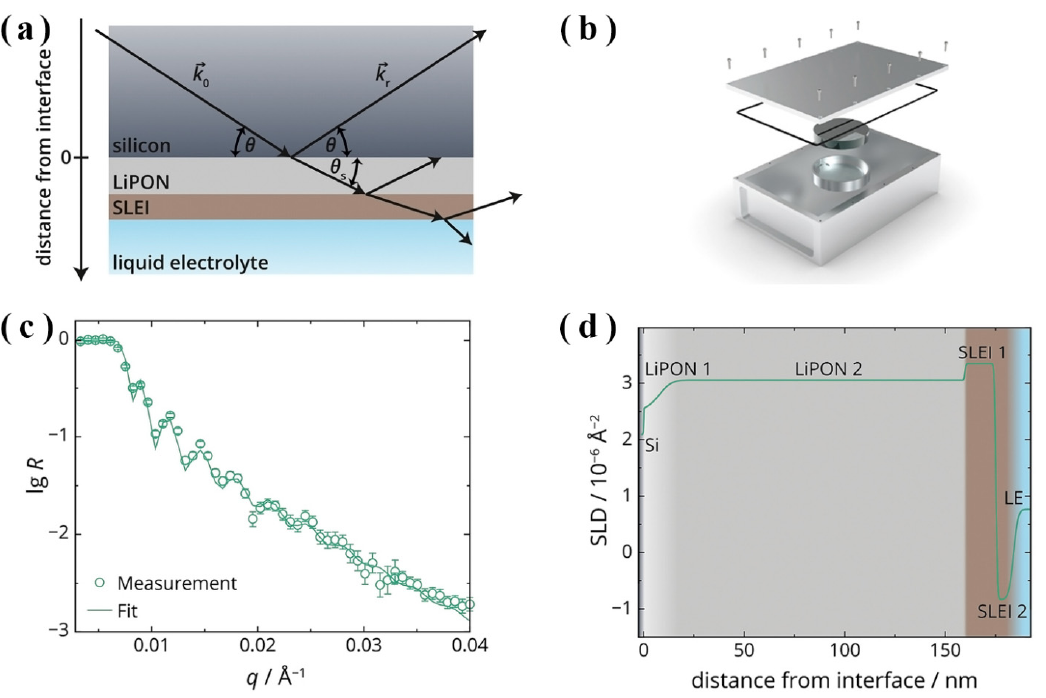
Figure 6. Measurement set-up for: ( a ) NR studies and ( b ) airtight measurement cell. In situ NR curve of ( c ) sputtered LiPON film dipped into LE for 3 h and ( d ) changes of SLD throughout the Si/LiPON/SLEI/LE model (adapted with permission from Ref. [36]. 2019 American Chemical Society).